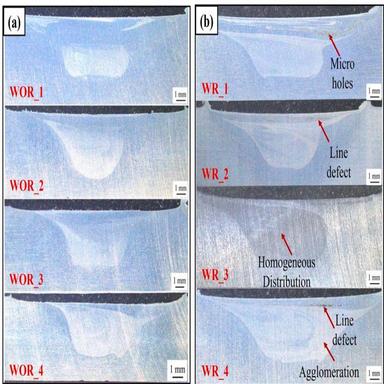
Stereo zoom macrographs of FSPed samples: (a) WOR conditions (b) WR conditions.